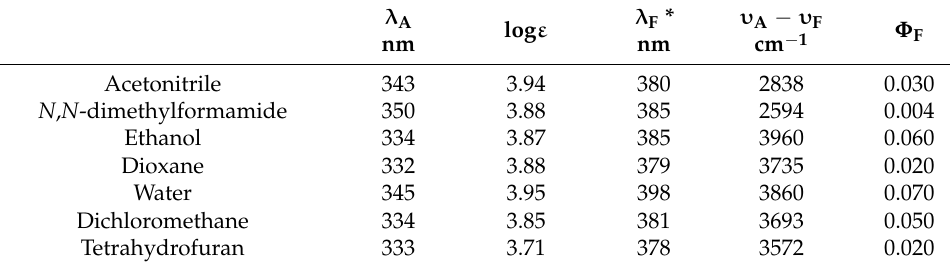
Table 1. Photophysical characterization of NI1 in organic solvents.